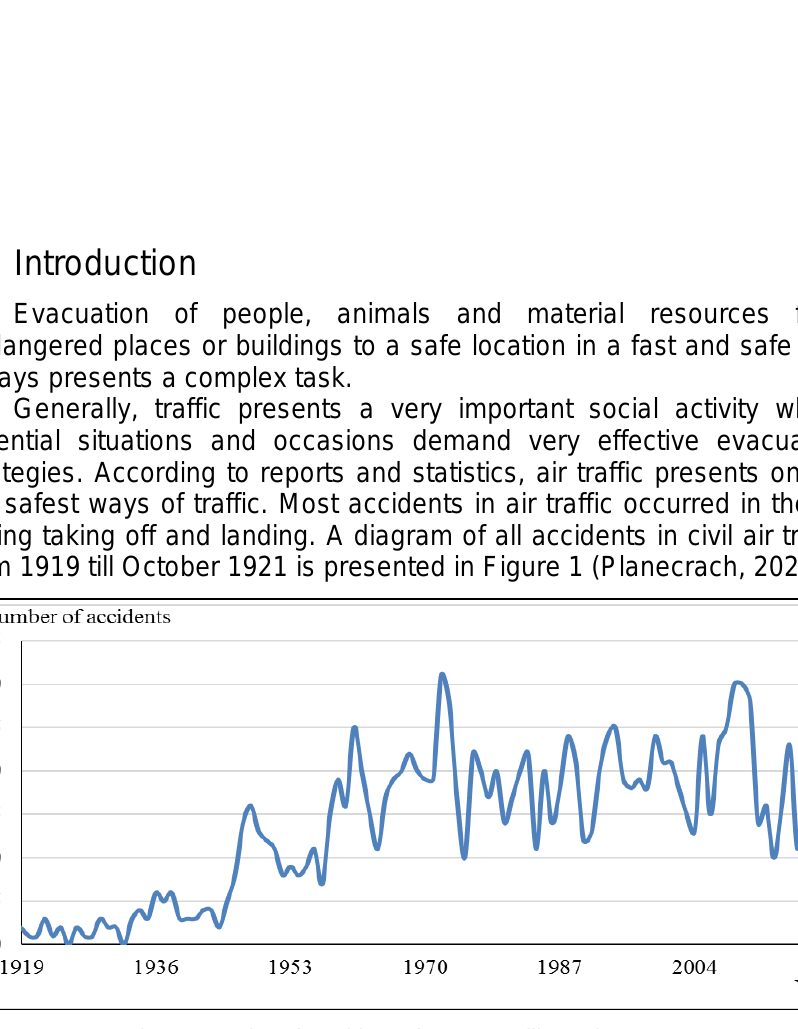
Figure 1 – Aircraft accidents from 1919 till October 2021 Рис. 1 – Авиакатастрофы с 1919 по октябрь 2021